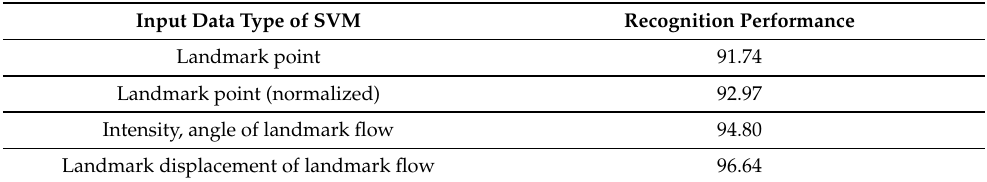
Table 6. SVM-based facial expression recognition performance in different feature data types of facial geometry.